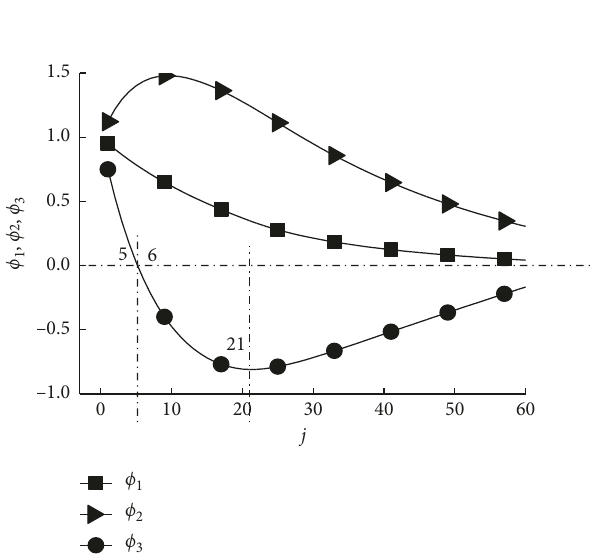
Figure 7: ϕ , ϕ , and ϕ on each contact face as a function of 1 2 3 contact-surface number j for single-circle soil